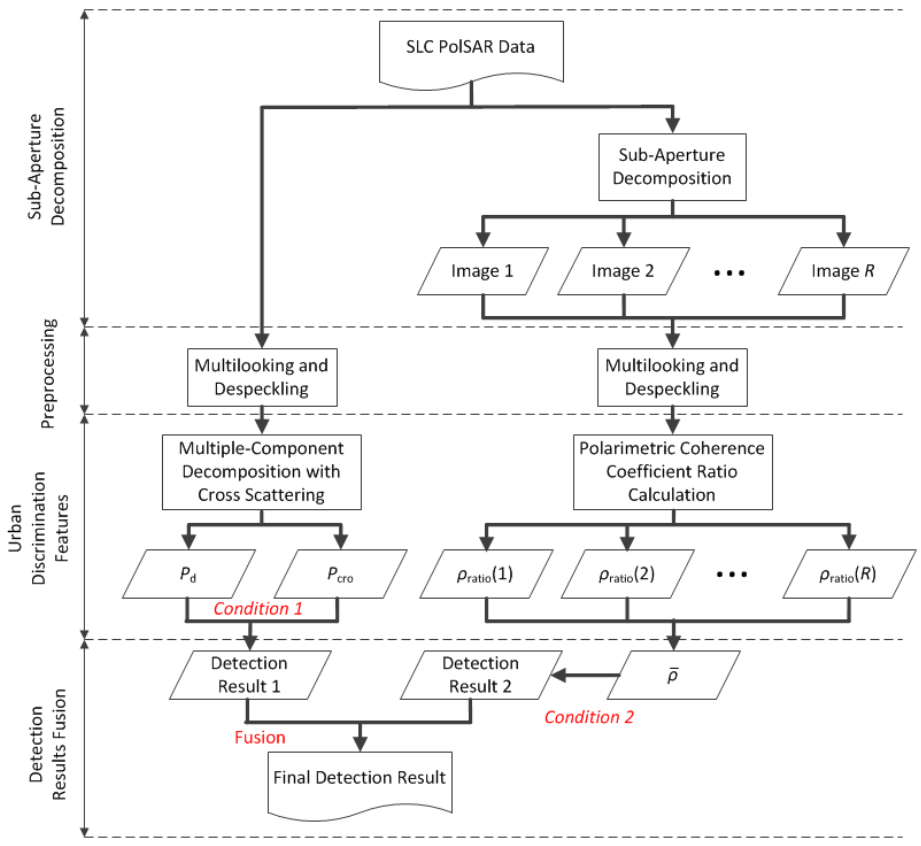
Figure 1. Flowchart of the proposed built-up area extraction method.